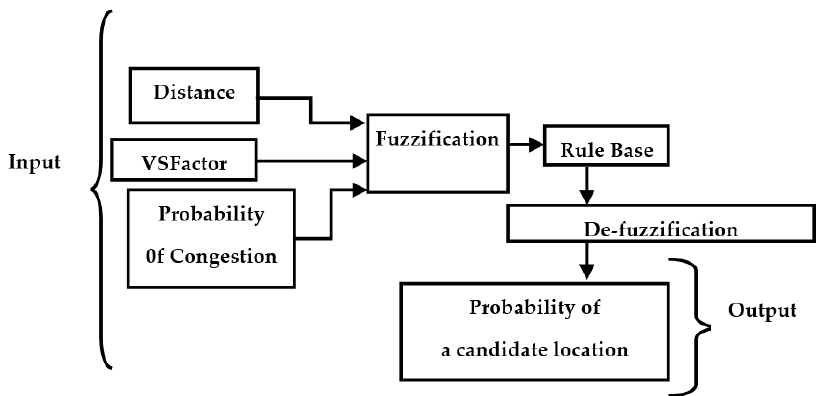
Figure 3. Mamdani fuzzy inference for placement of CSs [102].